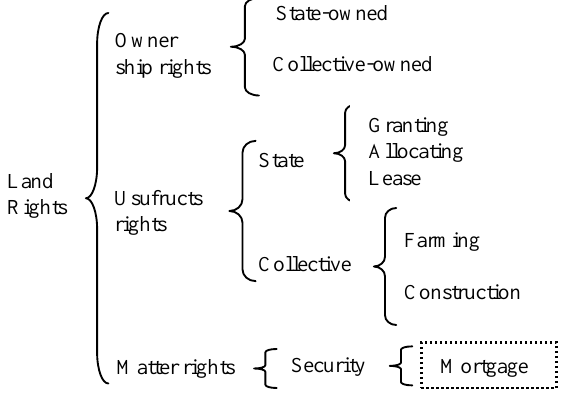
Figure 1. Land rights involved in cadastral